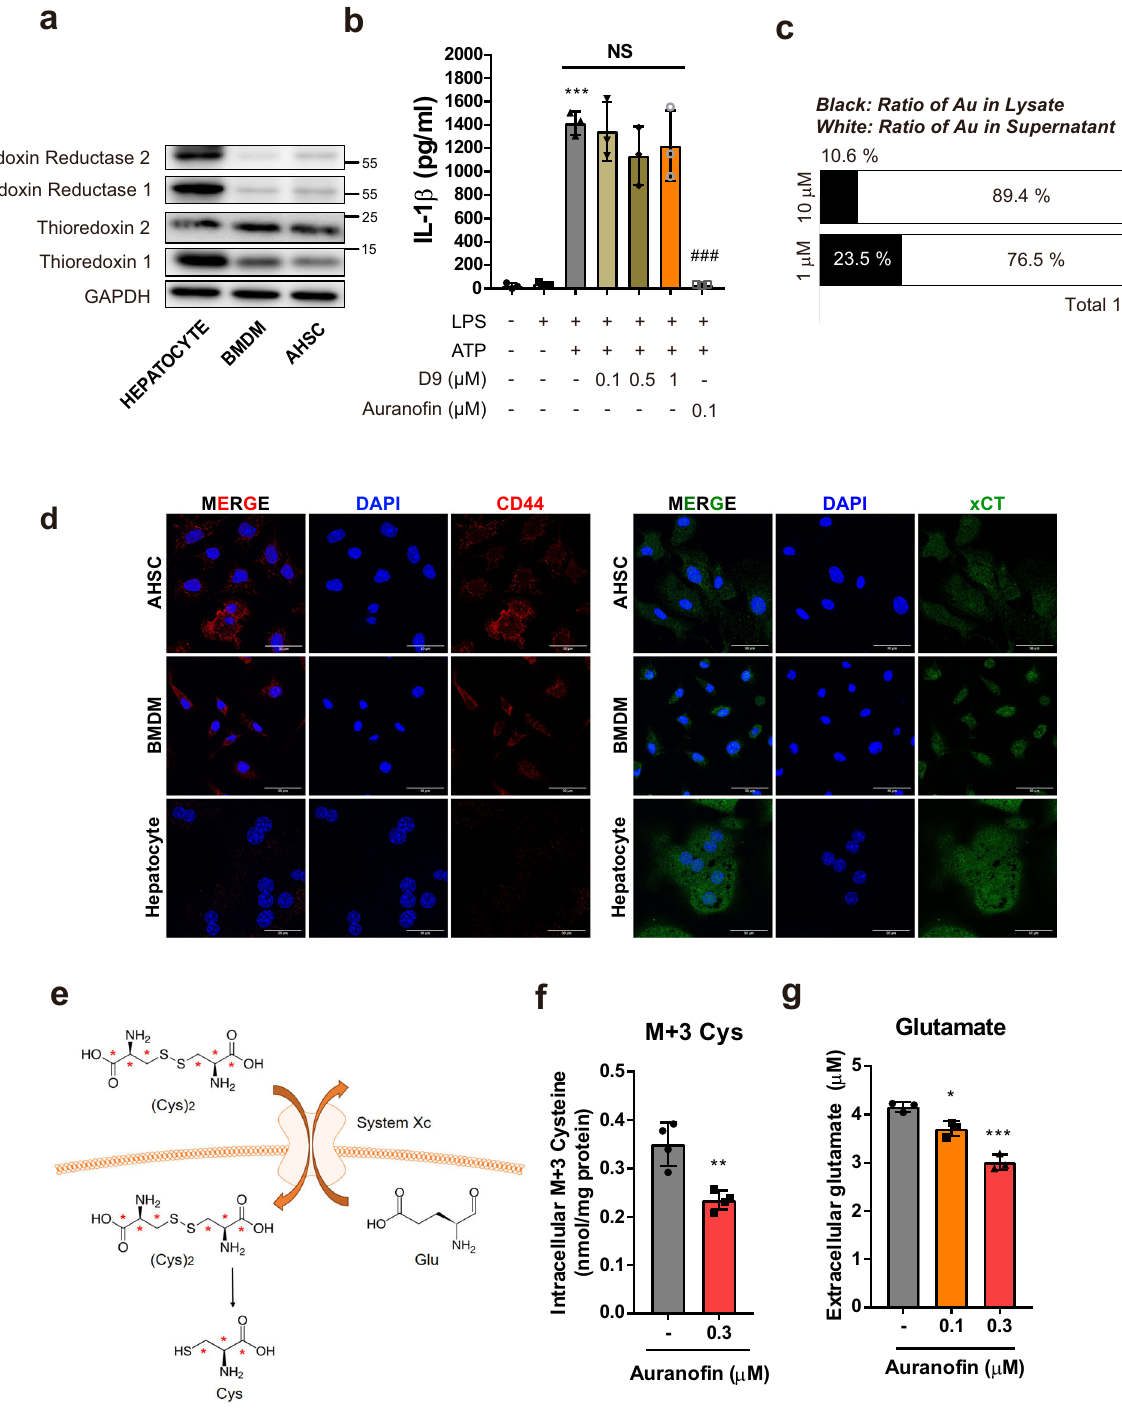
Fig. 7 The primary target of aurano fi n is system Xc in macrophages and activated HSCs. a Intracellular protein levels of thioredoxins and thioredoxin reductases in hepatocyte, BMDM and activated HSC. b Effects of thioredoxin reductase inhibitor, D9 on ATP triggered IL-1 β release of LPS-primed BMDM, n = 3. Data are presented as mean ± SD, analyzed by one-way ANOVA followed by Tuckey ’ s test; *** p < 0.001, compared to control; ### p < 0.001, NS; not signi fi cant compared to NLRP3 in fl ammasome-induced group. c BMDMs were treated with 1 or 10 µ M aurano fi n for 1 h. Ratio of gold elements in supernatant and cell lysates of BMDM were evaluated using ICP-MS. d Detection of xCT and CD44 in hepatocyte, BMDM and AHSC by immuno fl uorescence staining. Scale bar = 30 µ m. e , f Using stable isotope of cystine (M + 6), intracellular M + 3 cysteine were measured in BMDM after treatment with aurano fi n (0.3 µ M) for 15 min, n = 4. Cys; cysteine. g After exposure of BMDM with aurano fi n for 3 h, extracellular glutamate levels were measured by glutamate assay kit in supernatant of BMDM, n = 3. Data are presented as mean ± SD ( f and g ), analyzed by unpaired student t -test; * p < 0.05, **< p < 0.01 and, *** p < 0.001 compared to